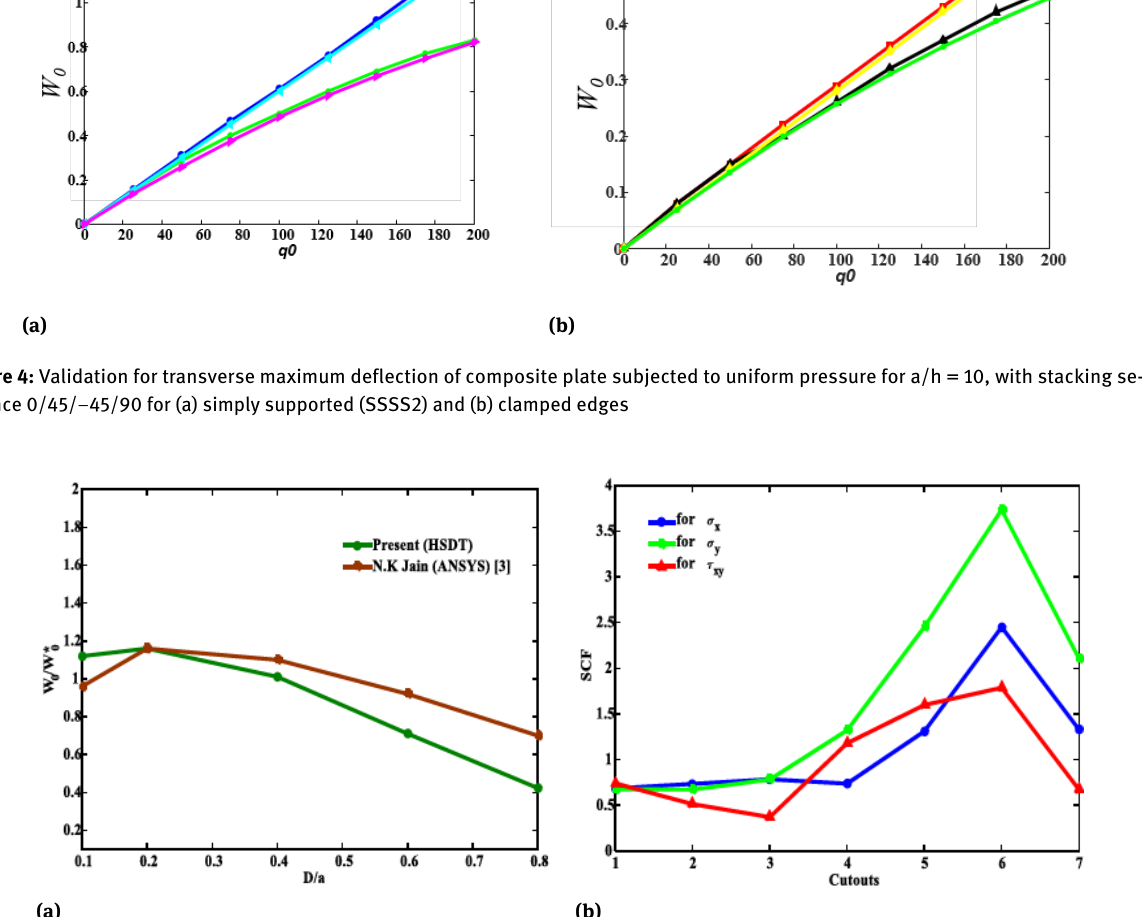
Figure 5: (a) Effect of D/A ratio on W 0 / W * supported